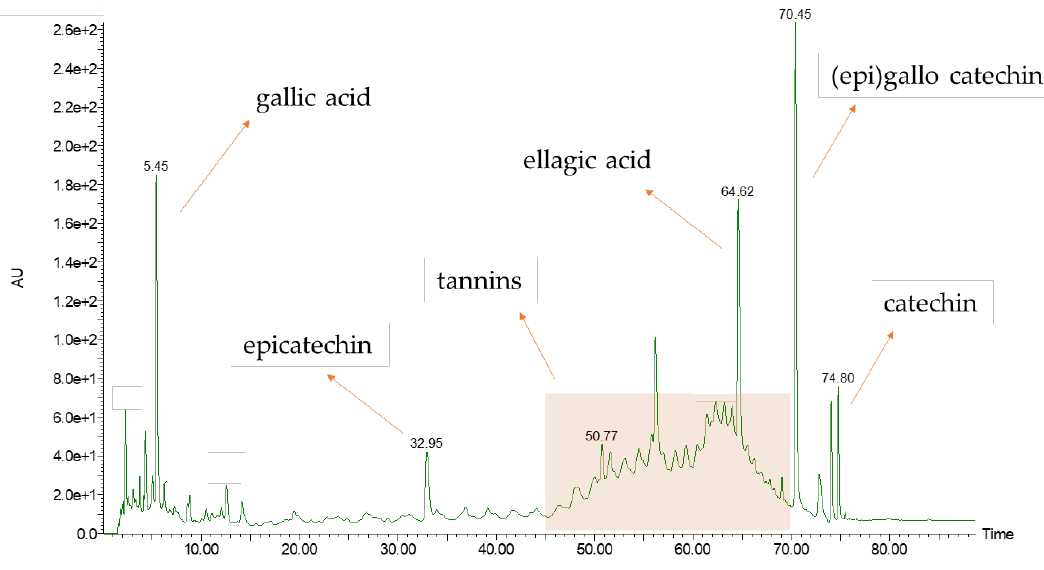
Figure 6. LC-MS of chestnut peel extract, DAD chromatograms of extract at 150 °C, 30 min. Table 4. Main components of chestnut optimized extract under subcritical conditions . Table 3. Kinetic parameters of the Peleg model. Determined for 1:20 and 1:30 extractions at 150 ◦ C. S/L Ratio